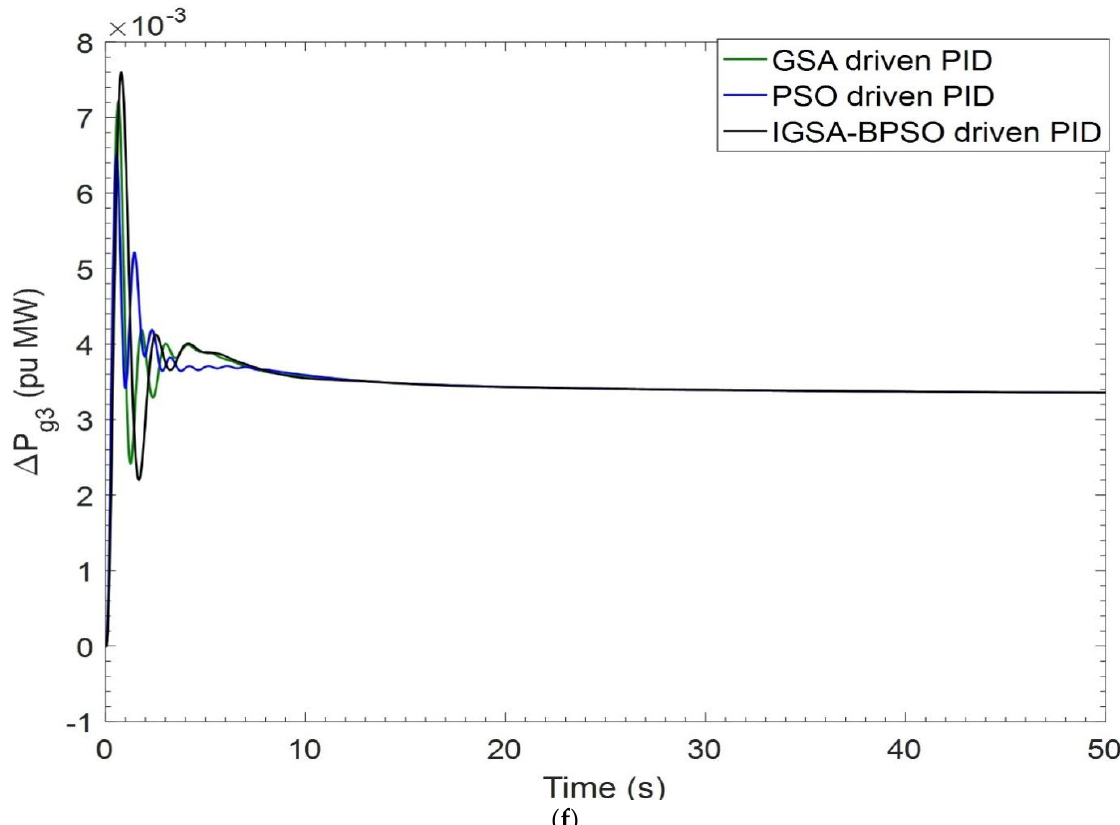
Figure 5. ( a ) Deviation in frequency Δ F 1 for PBT case; ( b ) deviation in frequency Δ F 2 for PBT case; ( c ) deviation in tie-line power Δ P tie for PBT case; ( d ) deviation in power related to GENCO—1 for PBT case; ( e ) deviation in power related to GENCO—2 for PBT case; ( f ) deviation in power related to GENCO—3 for PBT case.